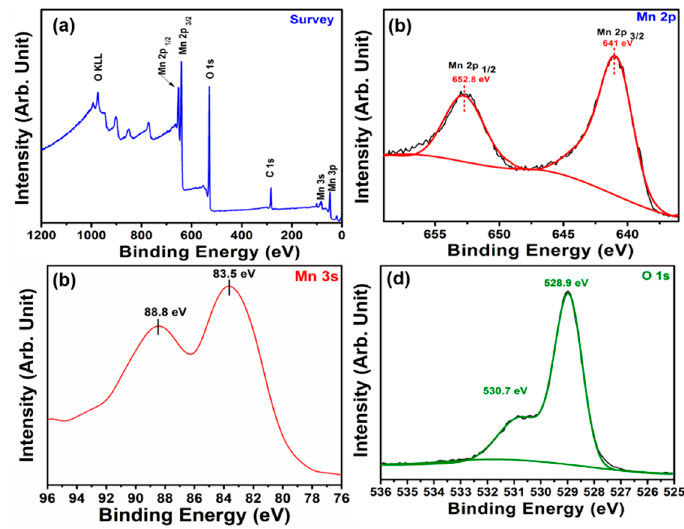
Figure 5. ( a ) Survey, ( b ) high resolution Mn 2 p , ( c ) Mn 3 s , and ( d ) O 1 s XPS of the synthesized mesoporous Mn 2 O 3 materials.